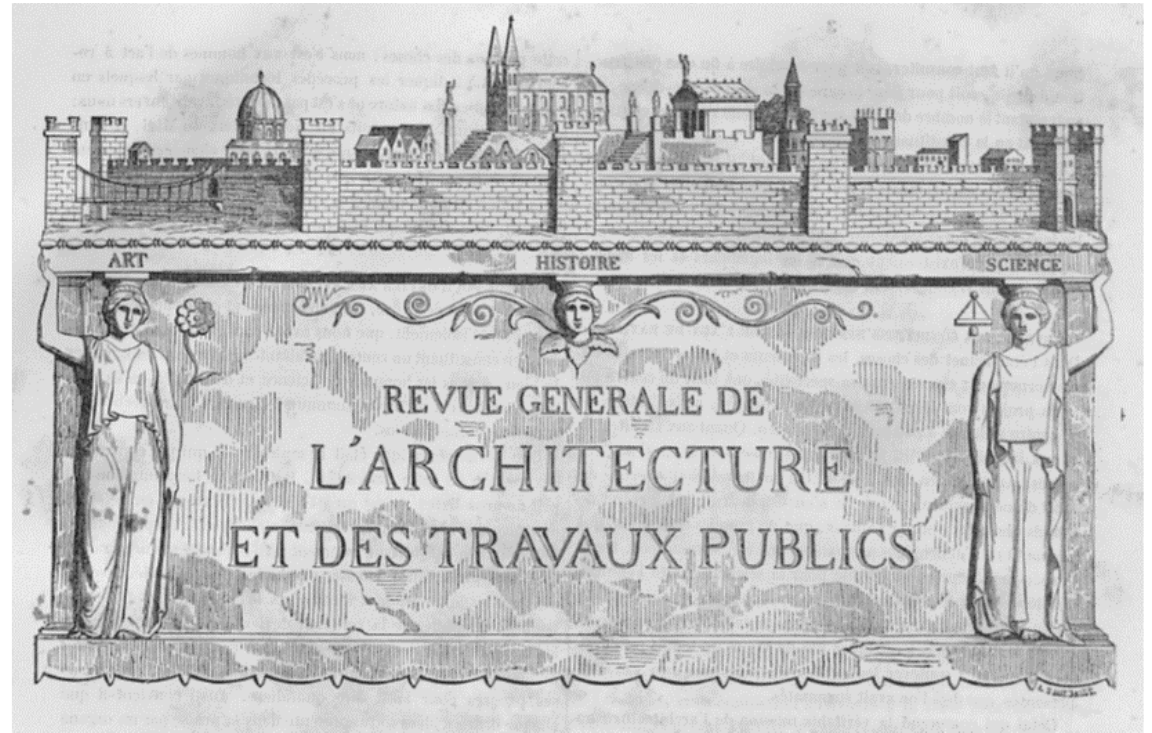
Figure 6. Main header engraving in the first issue of the magazine “Revue Générale de l’ architecture et des Travaux Publics”, France. Source: “ Revue Générale de l ’ architecture et des Travaux Publics ” , France, 1840. Vol.1, col.1. Edited by César Daly. Reference [15].